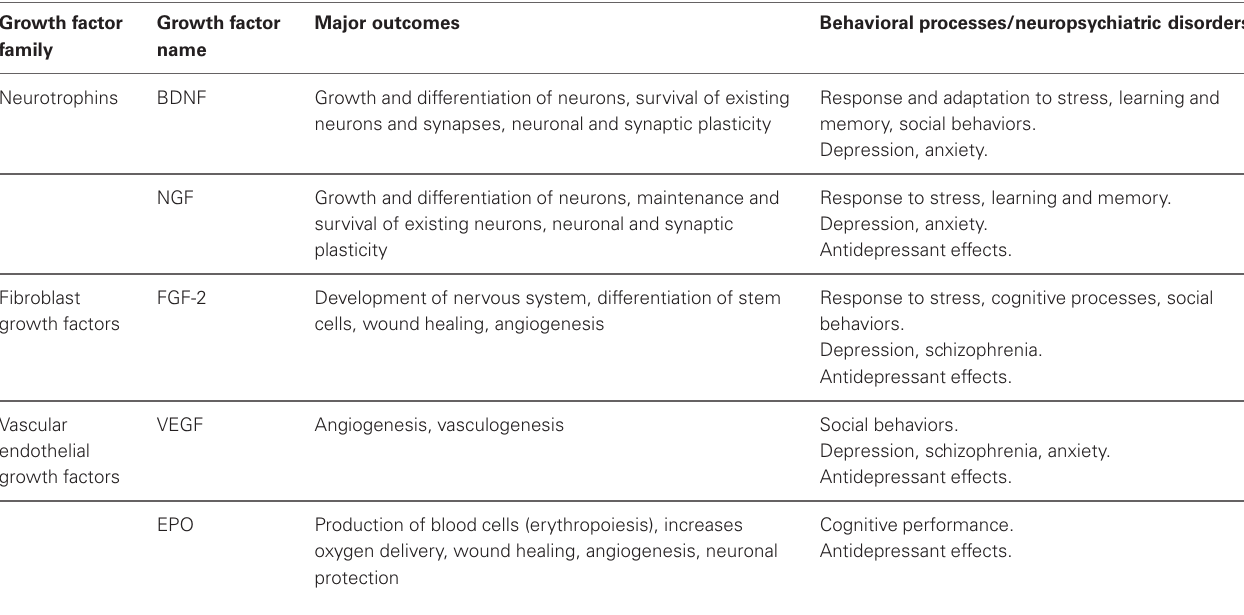
Table 2 | Subset of growth factors that had been implicated in depressive illnesses: potential roles in behavioral processes and/or neuropsychiatric